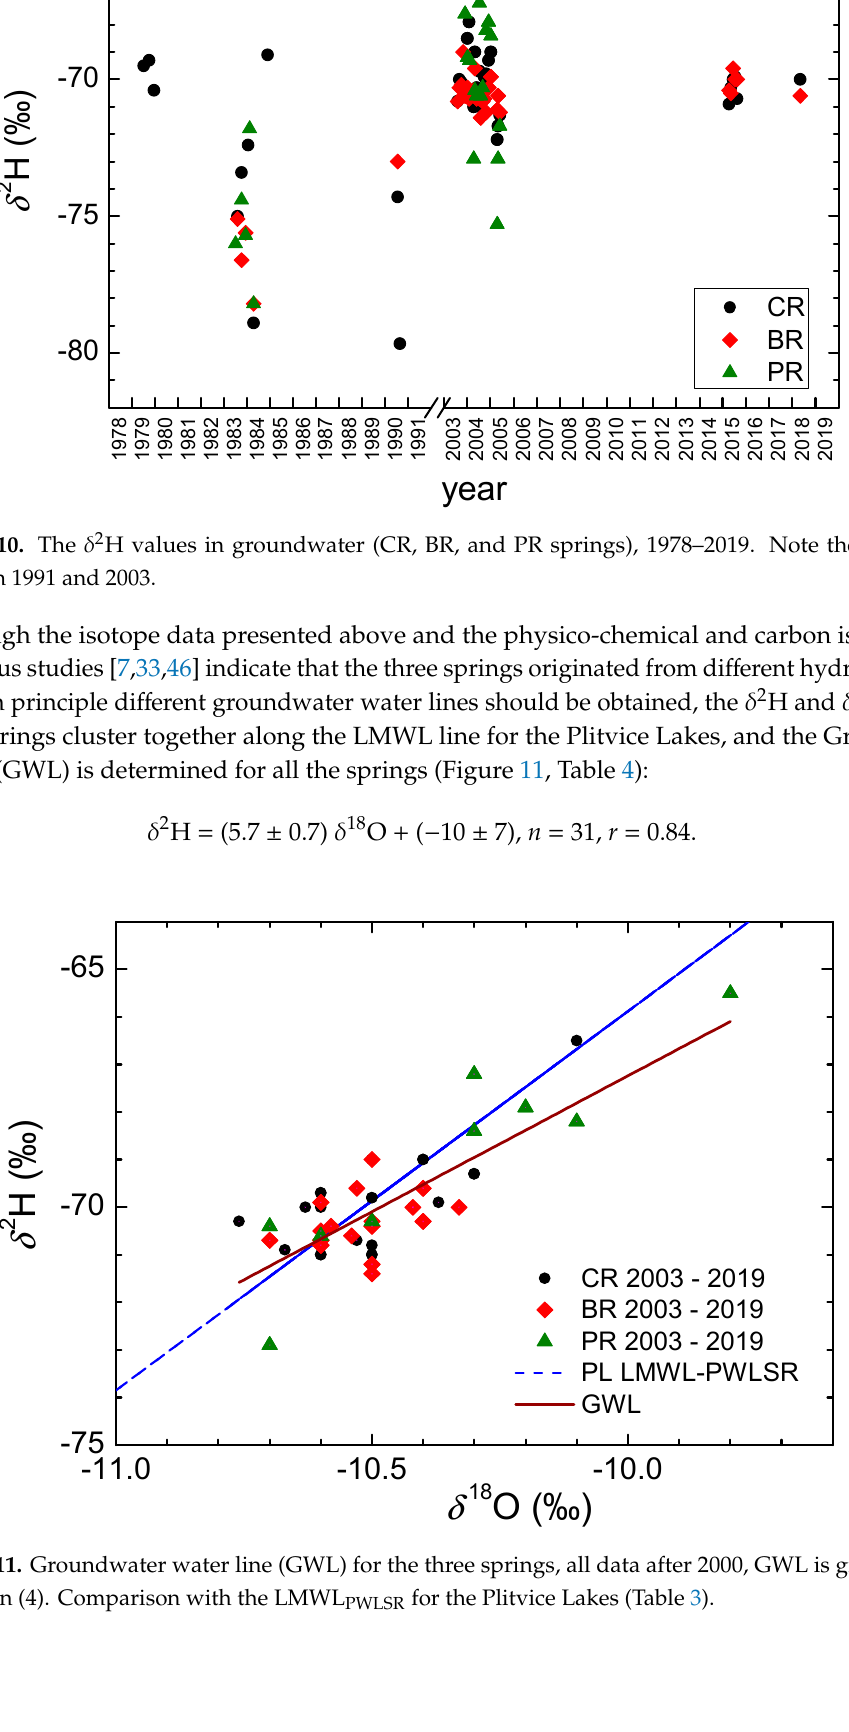
Figure 11. Groundwater water line (GWL) for the three springs, all data after 2000, GWL is given by Equation (4). Comparison with the LMWL PWLSR for the Plitvice Lakes (Table 3).